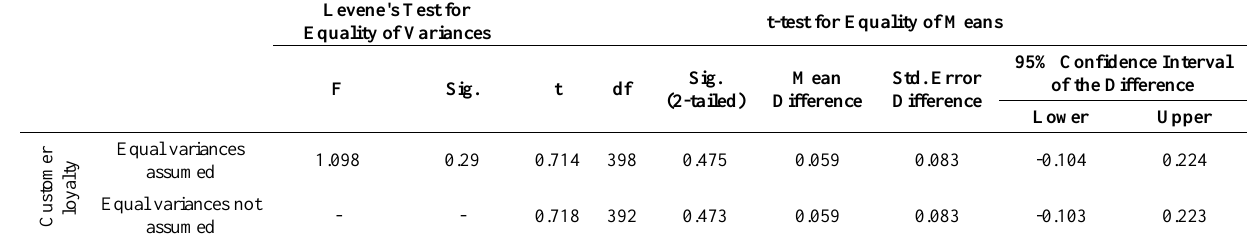
Table 10. Independent Samples